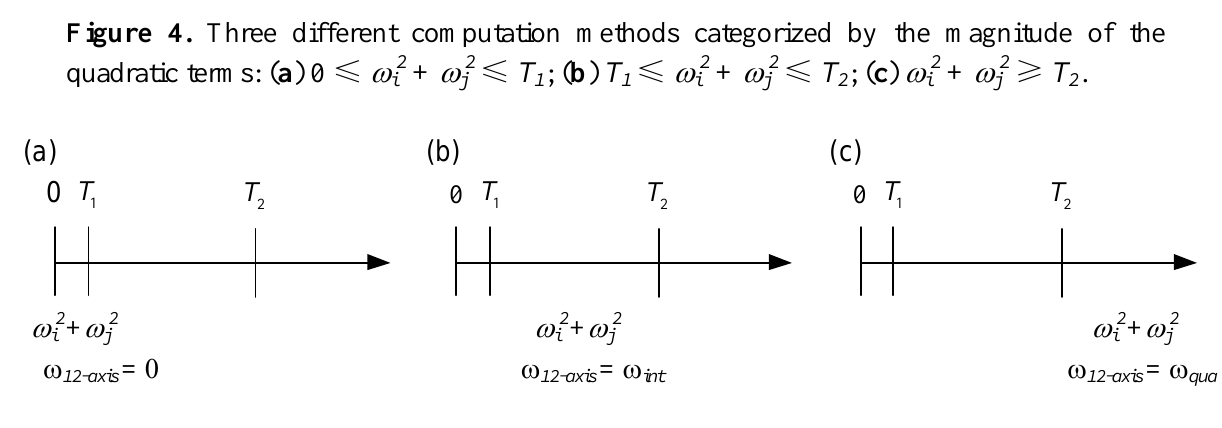
Figure 4. Three different computation methods categorized by the magnitude of